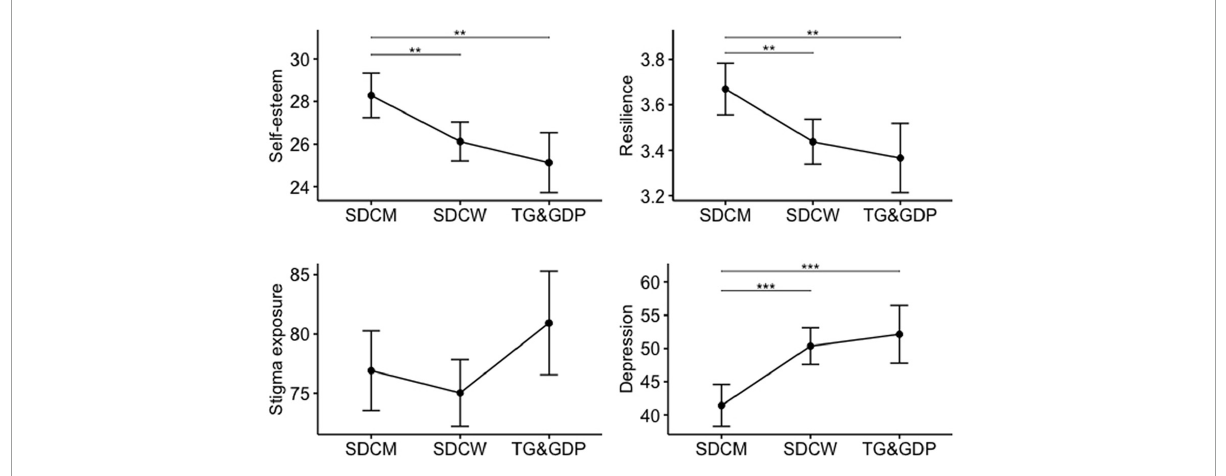
FIGURE1 Comparison of self-esteem, resilience, depression, and stigma exposure across separate groups of participants (adjusted for age). SDCW, Sexually Diverse Cisgender Women; SDCM, Sexually Diverse Cisgender Men; TG and GDP, Transgender and Gender Diverse Persons; ** p < 0.01, *** p < 0.001.